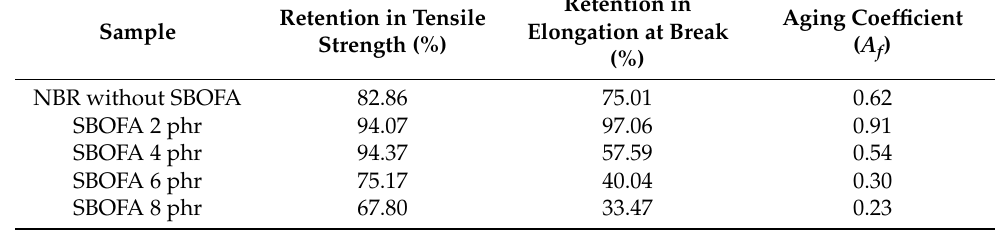
Table 7. Retention in mechanical properties (tensile strength and elongation at break) and aging coefficient ( A f ) of the NBR vulcanizates with varying SBOFA loadings.